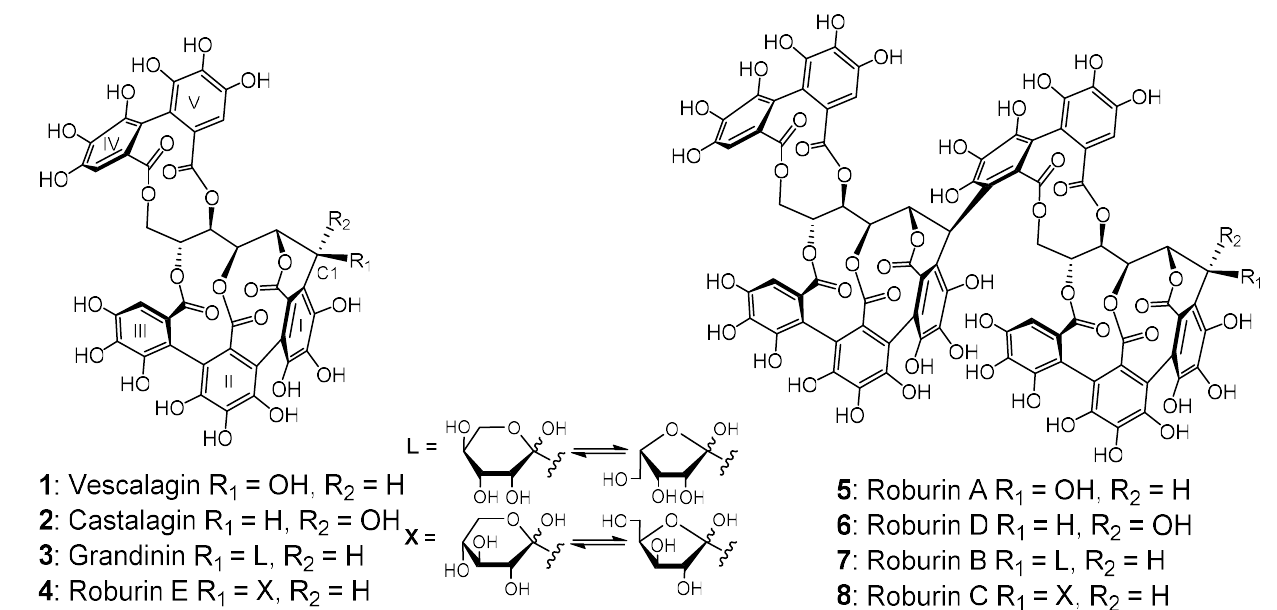
Figure 1. Structure of the eight C-glucosidic ellagitannins.